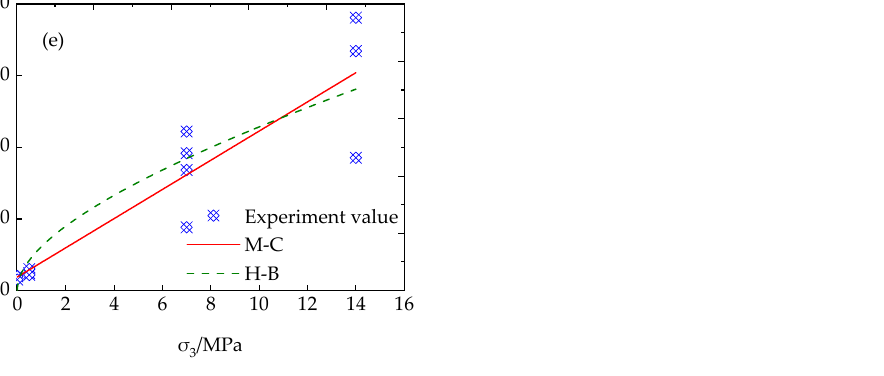
Figure 9. Fitting curves of the peak strengths of the mudstone with different water contents: ( a ) moisture content: 0%; ( b ) moisture content: 0.19%; ( c ) moisture content: 1.06%; ( d ) moisture content: 1.32%; and ( e ) moisture content: 1.40%.